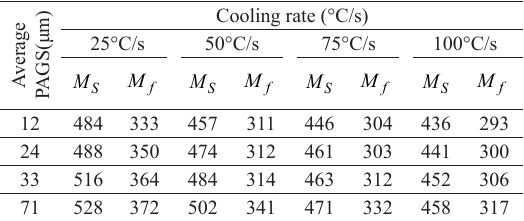
Table 2. Martensite start and finish temperatures as a function of average PAGS and applied cooling